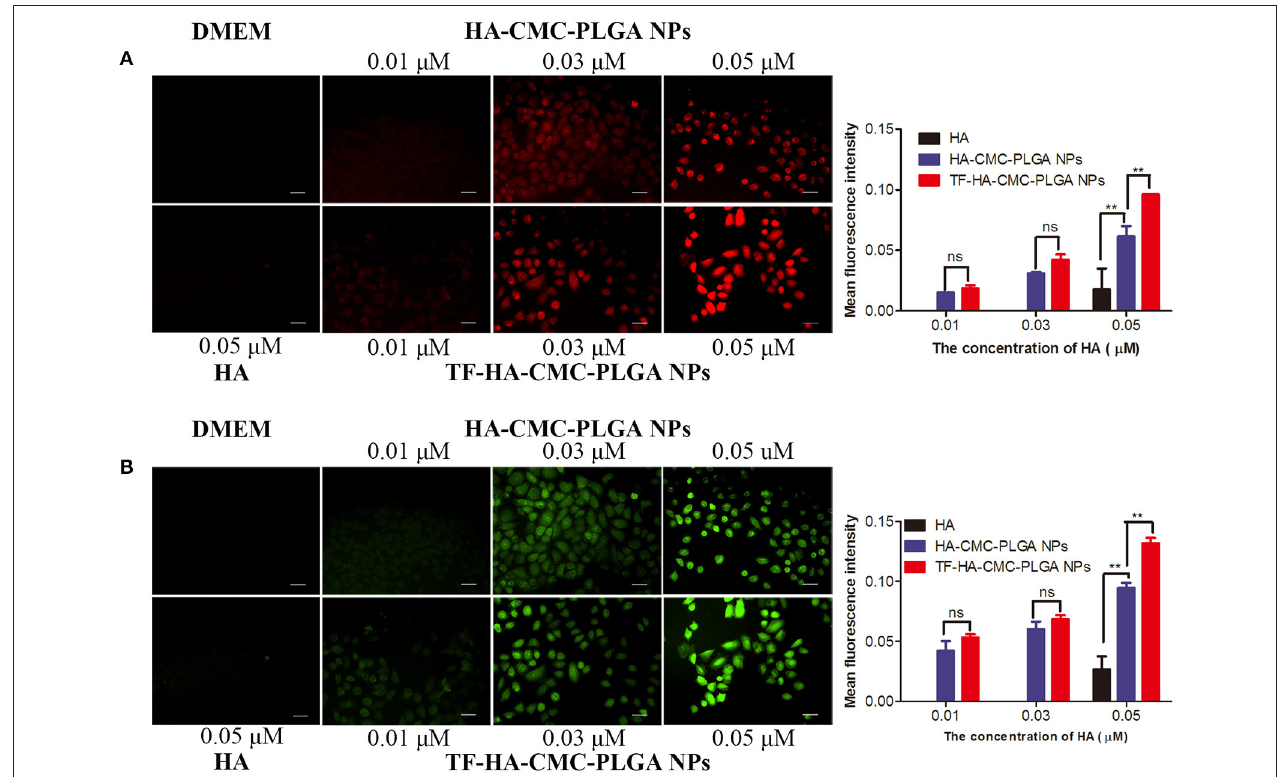
FIGURE 6 | (A) Detection of cellular uptake with HA fluorescence and semi-quantitative analysis of red fluorescence intensity with Image J software on A549 cells incubated with DMEM, HA, HA-CMC-PLGA NPs, and TF-HA-HA-CMC-PLGA NPs at different concentrations; (B) Detection of intracellular reactive oxygen species with DCFH-DA fluorescence probes and semi-quantitative analysis of green fluorescence intensity with Image J software on A549 cells incubated with DMEM, HA, HA-CMC-PLGA NPs, and TF-HA-HA-CMC-PLGA NPs with different concentrations. The cells were exposed to 470nm LED (90 mW/cm 2 ) for 15min. Each data point (mean ± SD) was calculated for triplicate ( n = 3). ** p < 0.01; ns p > 0.05. Scale bar = 20 µ